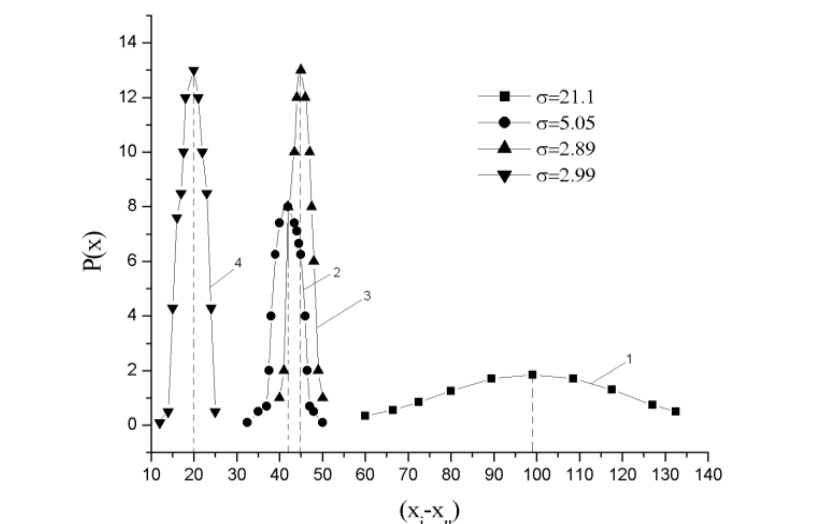
Fig. 2. The distribution of averaged over the plate static current transfer ratio of the base (B N ) 30 bipolar ADS (advanced low power Schottky) transistors test structure 556P Т 7 between 10 plates of the same batch with different electron fluence: : 1 – F е =0, 2 - F е =10 14 е / см 2 , 3 - F е 14 е / см 2 , 4 - F е =10 15 е / см 2 (j = 10 2 A/ см 2 , S эм 2 , Е е = 5 М eV).